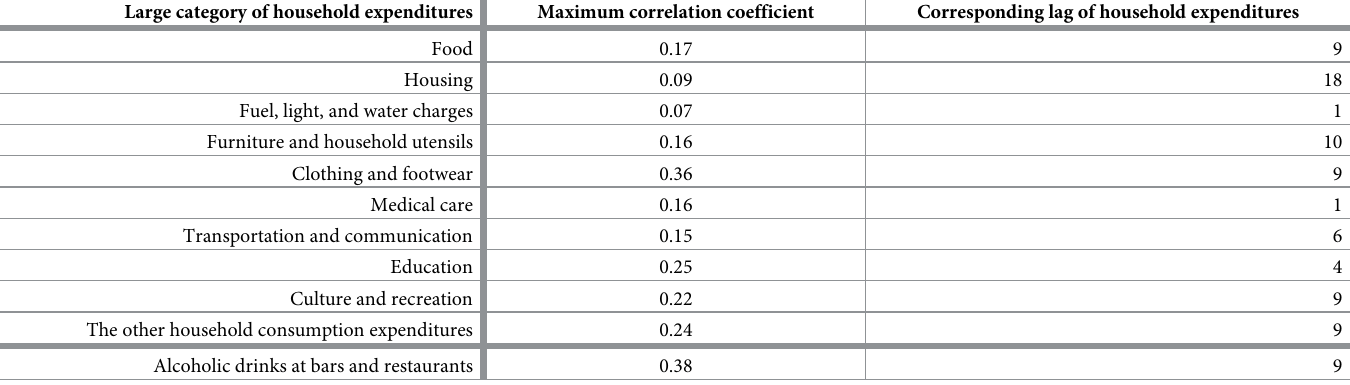
Table 1. Cross-correlation coefficients between the log difference over seven days in the number of new confirmed cases and lagged values of each large category of household expenditures per household in Japan. Large category of household